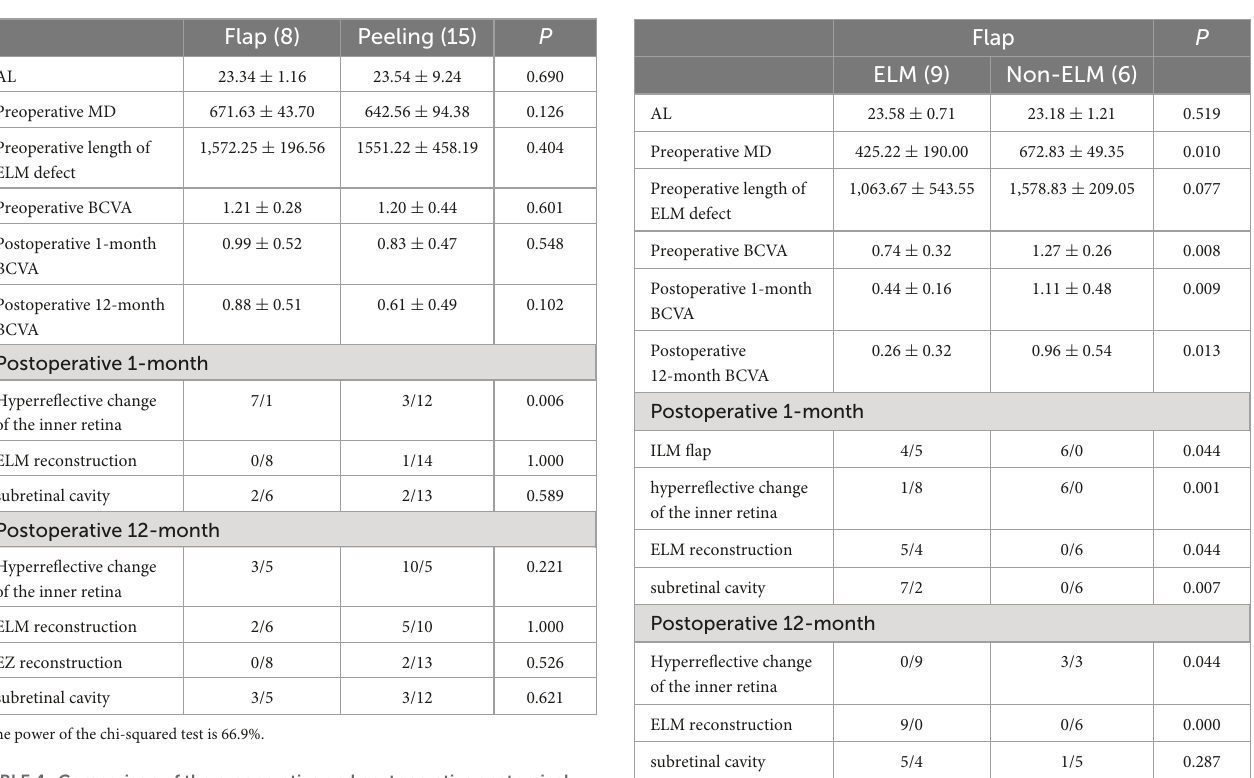
TABLE 5 Comparison of the preoperative and postoperative anatomical structures and visual function of the ELM and non-ELM subgroups of the flap